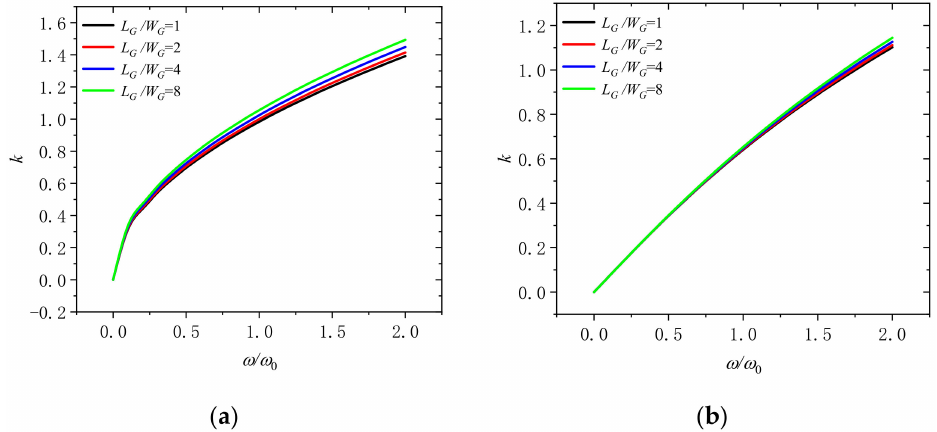
Figure 7. Wavenumber dispersion in a rotating microbeam with different length width ratio of GPLs ( L G / W G = 1, 2, 4, and 8) for ( a ) Ω / Ω 0 = 0 and ( b ) Ω / Ω 0 = 2. Figure 8 displays that the phase velocity and the group velocity varies with dimen- sionless frequency for different GPLs length-width ratio ( L G / W G = 1, 2, 4, and 8) under the